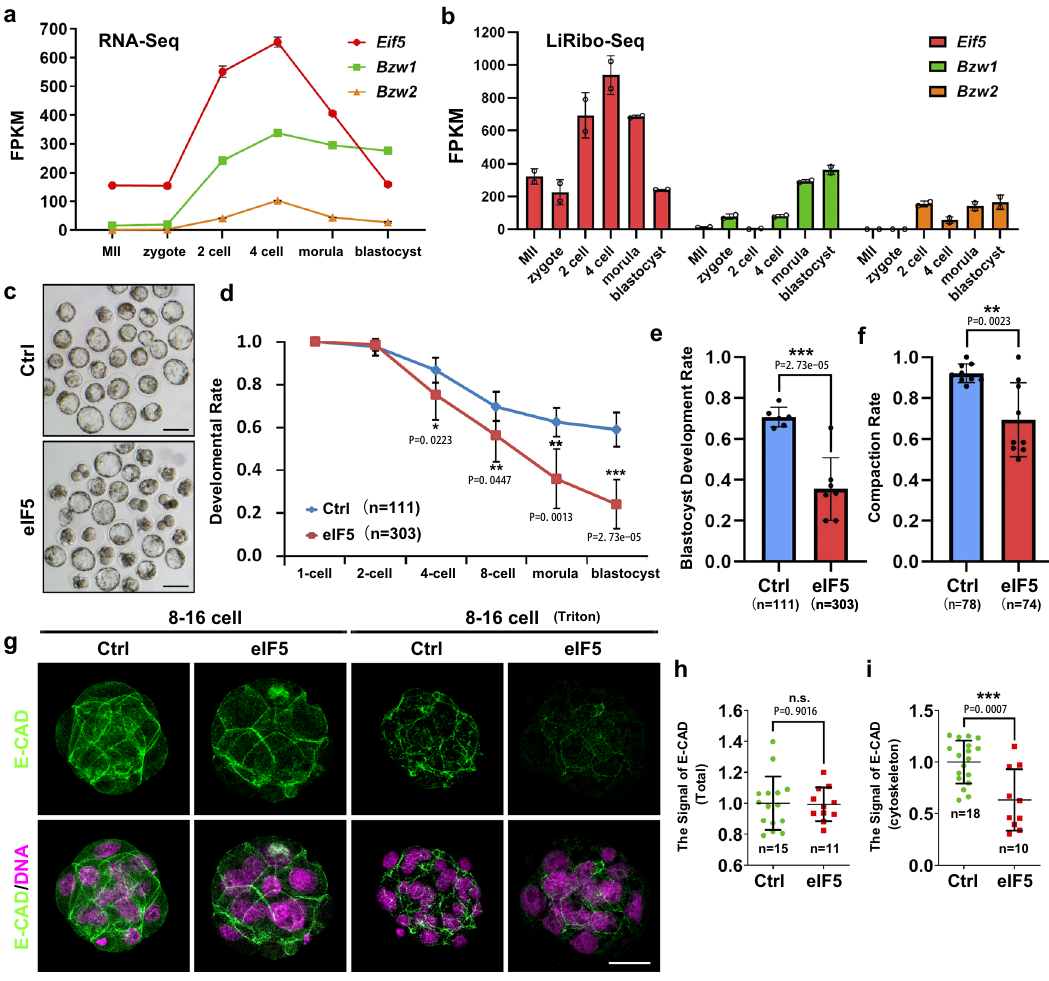
Fig. 5 | Overexpression of eIF5 mediated non-AUG translation initiation rate increasing can mimic the phenotype that preimplantation embryonic devel- opment and compaction rate decreased causing by the lake of BZW1. a The RNA-Seq from published data (GEO: GSE169632) shows the mRNA levels of Bzw1, Bzw2 ,and eIF5 duringearlyembryodevelopment. n =100 – 250oocytesorembryos in every sample. Two replicates ’ data are presented as mean values, by two-tailed Student ’ s t -test.Errorbars,S.D. b Low-inputribosomepro fi ling(LiRibo-seq)results from published data (GEO: GSE169632) showed the translational levels of Bzw1 , Bzw2 , and eIF5 during earlyembryo development. n =100-250 oocytes or embryos in every sample. Data are presented as mean values, by two-tailed Student ’ s t -test. Error bars, S.D . c Representative embryo DIC images at E4.5. Zygotes were micro- injectedwithmRNAsencodingmCherry(asacontrol)ormCherry-eIF5(700ng/ μ L) and cultured for 4 days. Scale bar, 100 μ m. d Zygotes were microinjected with mRNAs encoding GFP or GFP-eIF5 (700ng/ μ L) and then cultured for 4 days. The percentageofembryosthatreachedthe2-cell,4-cell,8-cell,morula,andblastocyst stages was calculated and is presented as the developmental rate. Data are pre- sented as mean values. * P <0.05, ** P <0.01, *** P <0.001, by two-tailed Student ’ s t -